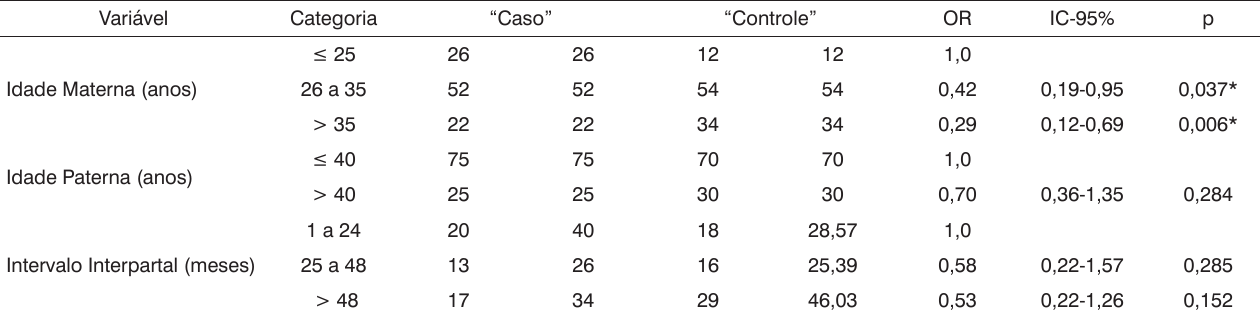
Tabela 5. Análise bivariada da idade materna, paterna e intervalo interpartal dos grupos “caso” e “controle”.